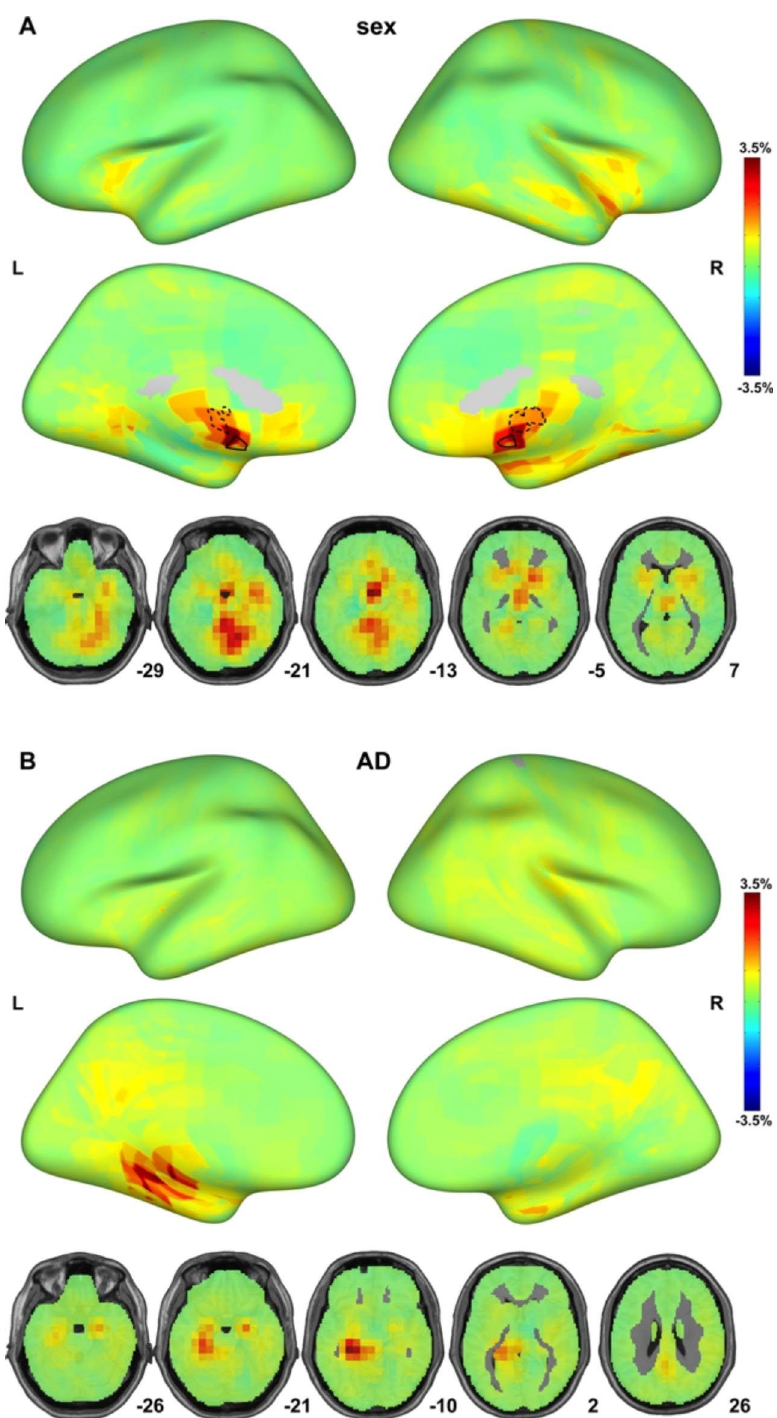
Fig. 4 Interpretation of the deep learning classifiers with occlusion maps. Classifier performance dropped con- siderably when the brain areas rendered in red were masked out of the model input. ( A ) Occlusion maps for the sex classifier. Hypothalamus and pituitary were marked in dashed line and solid line. ( B ) Occlusion maps for the Alzheimer disease